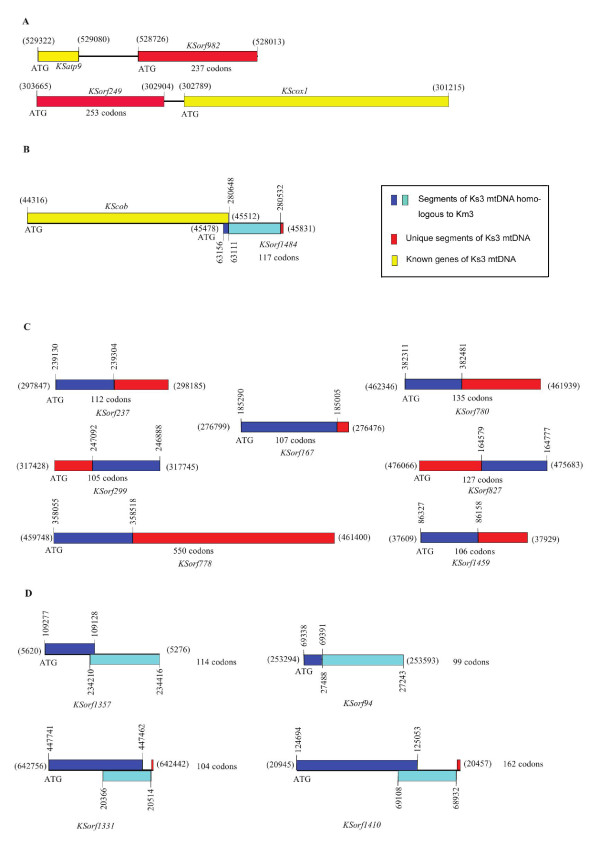
Unique ORFs of Ks3 mtDNA. (A) ORFs located in the vicinity of known genes; (B) ORFs overlapping with known genes; (C) partial sequences of ORFs that are homologous to Km3 mtDNA; (D) ORFs that are homologous to two discrete segments of Km3 mtDNA. Red bars indicate the unique sequences of Ks3 mtDNA. Blue bars and blue-green bars indicate the homology of Ks3 mtDNA to Km3 mtDNA. Yellow bars indicated known genes of Ks3 mtDNA. The vertical numbers show the coordinates of the homologous fragments of ORFs in the Km3 mtDNA MC molecule. The numbers in parentheses indicate the coordinates of ORFs in the Ks3 mtDNA MC molecule.